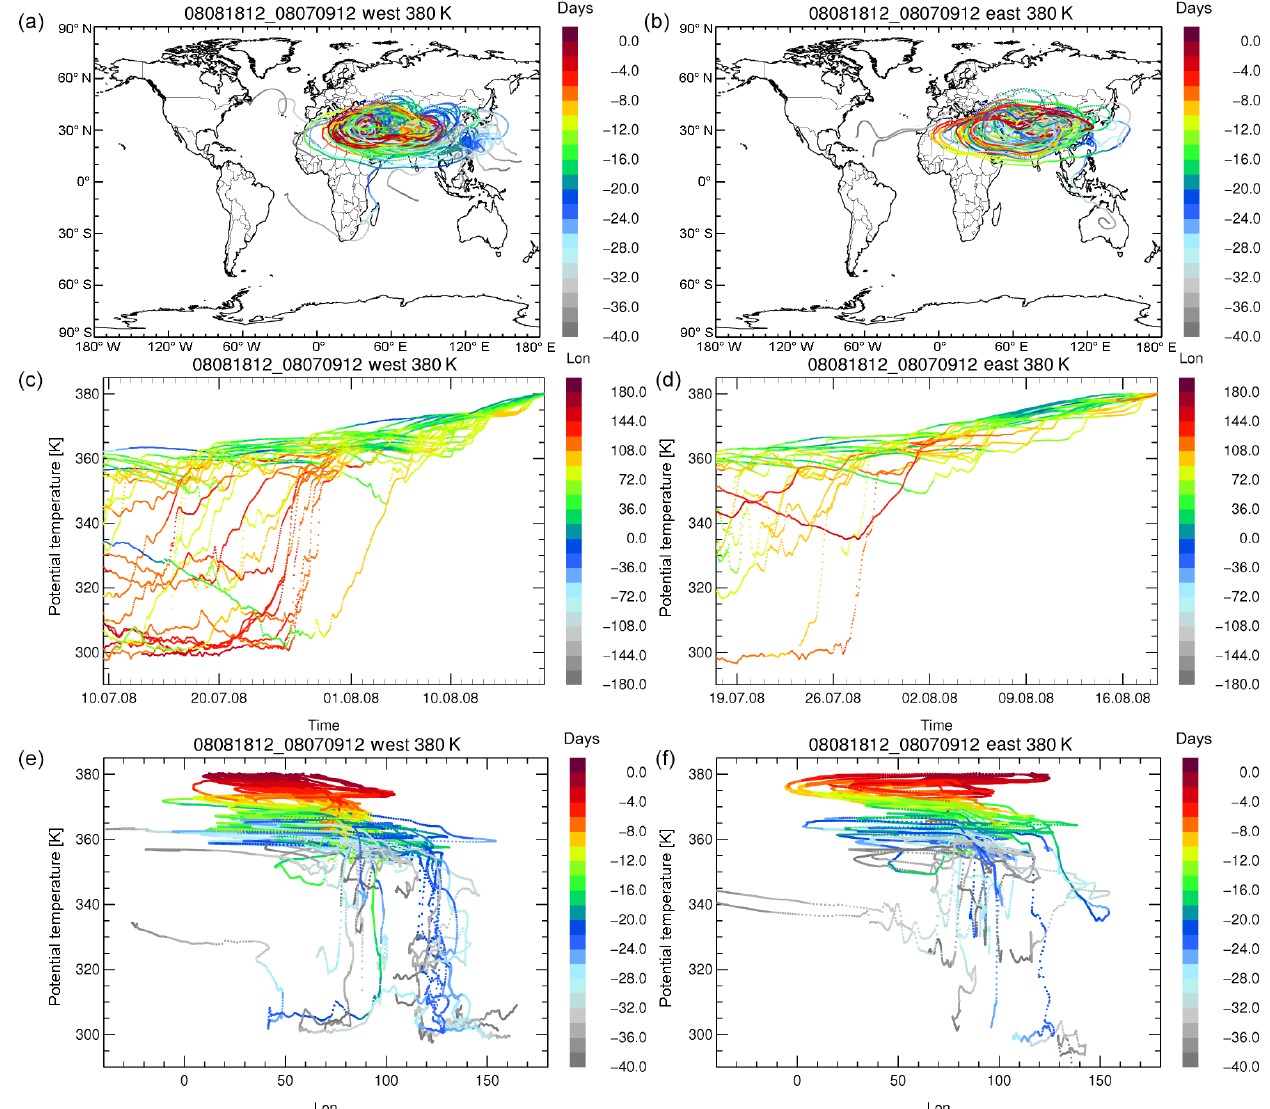
Figure 6. Different 40-day backward trajectories started at 380K in the western (a, c, e) and eastern (b, d, f) mode of the Asian monsoon anticyclone are shown colour-coded by days back from 18 August 2008 (a, b) . Further, potential temperature versus time (in UTC) along 40-day backward trajectories colour-coded by longitude (c, d) and potential temperature versus longitude, colour-coded by days back from 18 August 2008 (e, f) are shown. The trajectory positions are plotted every hour (coloured dots). Large distances between successive positions indicate rapid